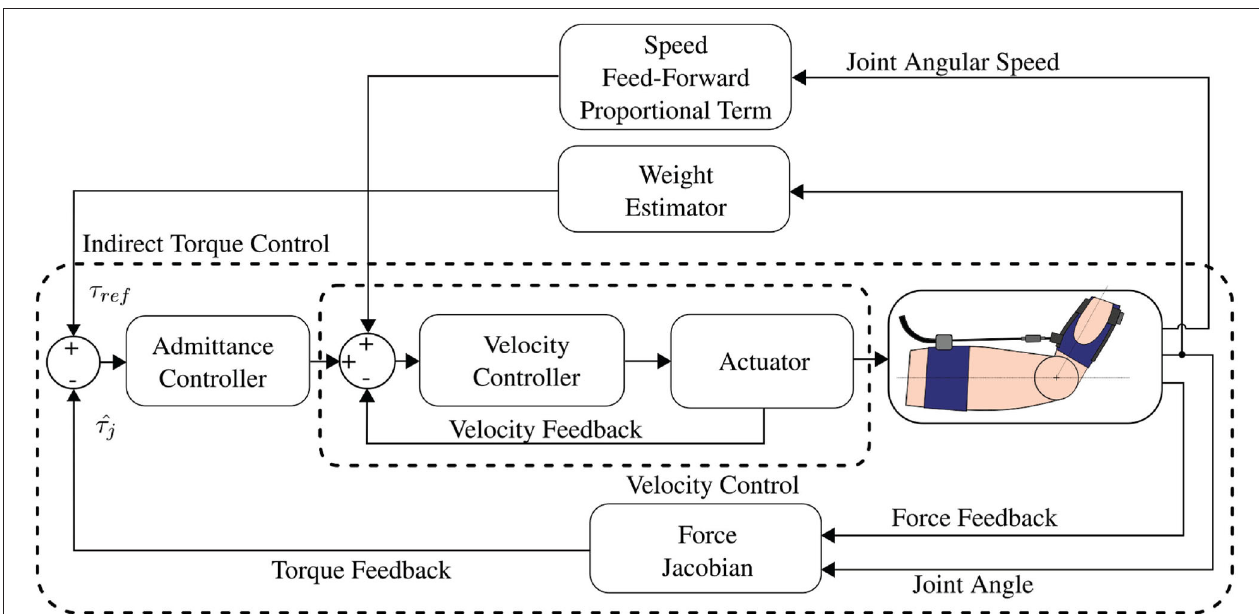
FIGURE 4 | Schema of the admittance controller for transparency and gravity compensation. An outer admittance control loop tracks a reference profile that is the sum of two contributes: the first compensates for the gravity of the arm and of the load, and the second improves transparency by providing the torque needed for human movement following. The admittance controller computes a motion reference as an interaction torque is sensed, according to the admittance specified by a PID controller. The inner velocity loop is tuned to be as stiff as possible to reject force disturbances like stiction and backlash.